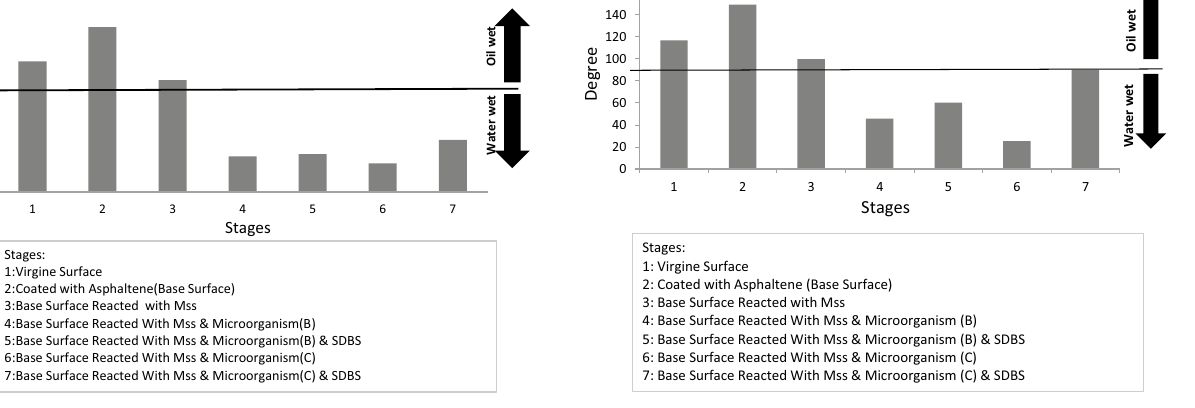
Fig. 13 Contact angle measurement for Ahwaz-Bangestan asphaltene samples